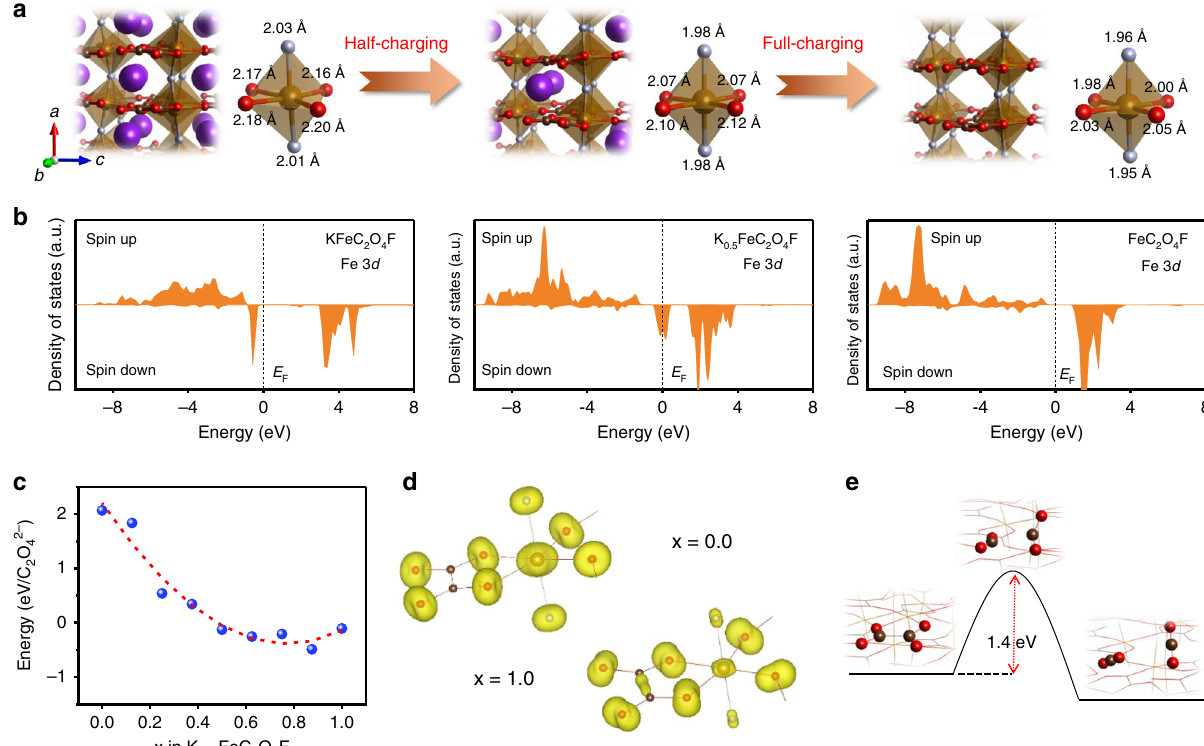
Fig. 5 First-principles calculations. a Calculated atomic structures of K 1 – x FeC 2 O 4 F in the pristine, half-charging and full-charging states ( x = 0, 0.5, 1), and b their corresponding partial density of states (DOS) projected onto the Fe 3 d orbitals. c The reaction energy of a C 2 O 4 2 − decomposing into 2CO 2 in the bulk of K 1 – x FeC 2 O 4 F as a function of the charge state x . d The partial charge density for electrons in the energy range between − 2.5 eV and the Fermi level (0 eV) of the pristine ( x = 0) and full-charging ( x = 1) states. e The reaction scheme and kinetics of a C 2 O 4 2 − decomposing into 2CO 2 in the bulk of K 0.125 FeC 2 O 4 F. Based on the Brønsted-Evans-Polanyi relation, the reaction barrier is linearly related to the reaction energy. Therefore, the reaction barrier in K 0.125 FeC 2 O 4 F with the lowest decomposition energy represents the minimum barrier in K 1 – x FeC 2 O 4 F.